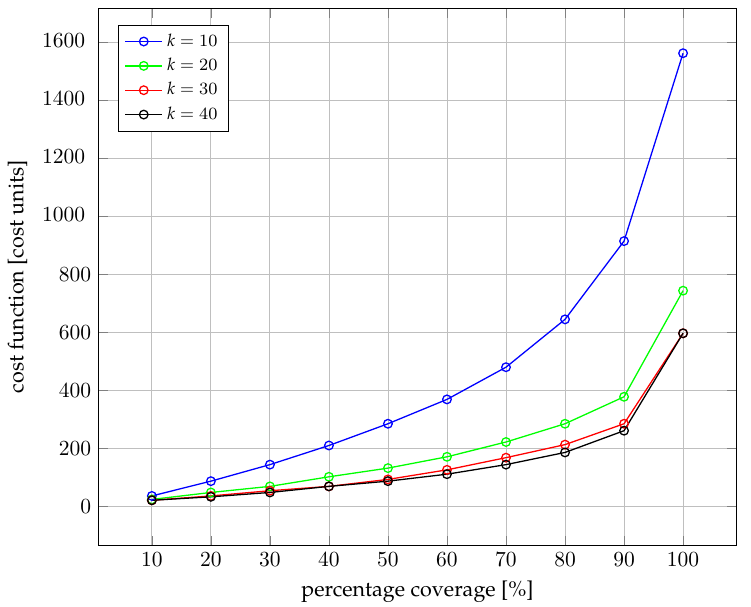
Figure 8. Optimal cost of IoT equipment deployment for the data set 2. Sampling frequency in a